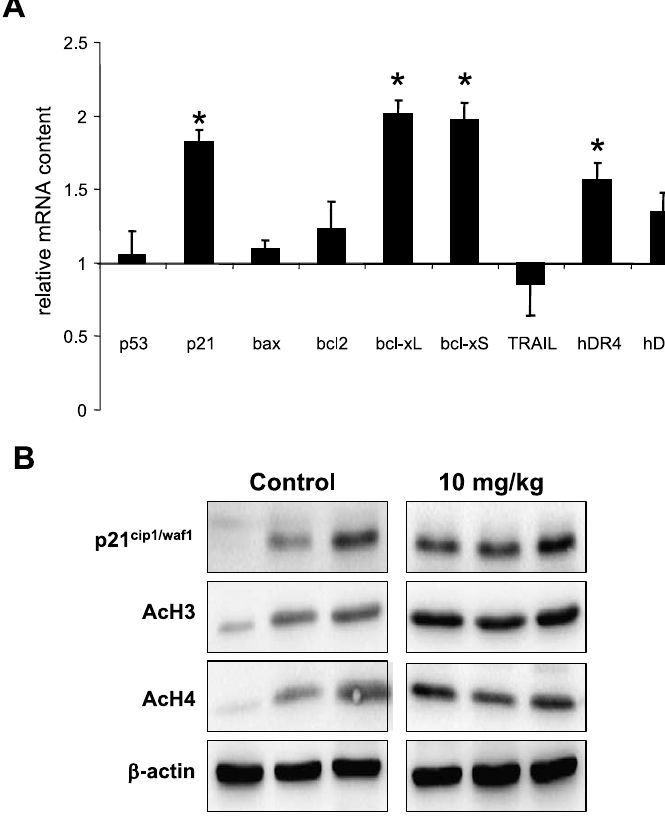
Fig. 7. Molecular analysis of panobinostat treated HepG2 xenografts. (A) Quantitative real-time RT-PCR analysis of panobinostat-related genes. Results were normalized to GAPDH mRNA expression and are presented as mean ± SEM of 8 animals/group relative to mRNA levels of control animals set at 1.0. * P < 0 . 05 vs. control. (B) Western blot analysis from 3 representative animals/group showing an increase in p21 cip1/waf1 and acetylated histone H3 and